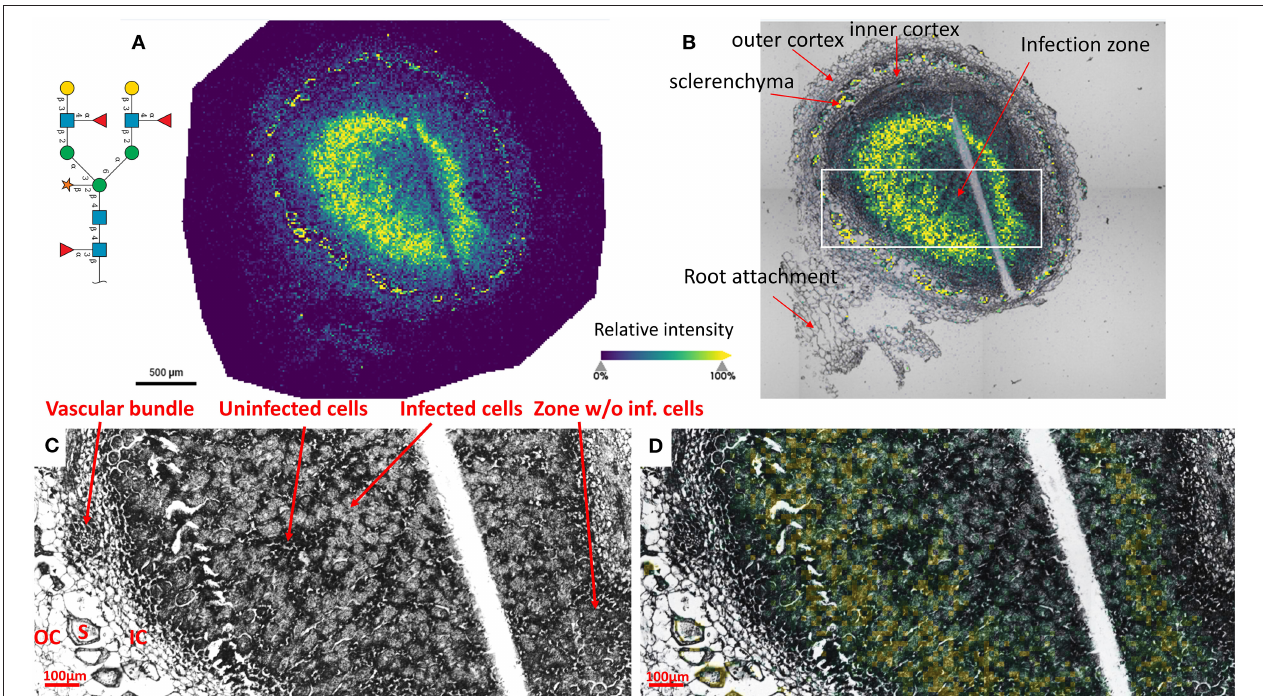
FIGURE 4 | (A) Spatial pattern of Hex:5 HexNAc:4 dHex:3 Pent:1 glycan in nifH- nodule at 15 µ m spatial resolution. (B) Morphologically and functionally different cell types and zones inside soybean root nodules are annotated. A white rectangle denotes an area that is enlarged on (C,D) for better visualization of fine morphological details. (C,D) Zoomed area inside the infection zone with annotated infected and uninfected cells indicate a higher abundance of N -glycans in the infected cells (bigger and lighter cells) compared to non-infected cells (smaller and darker). Vascular bundles, inner cortex (IC), outer cortex (OC), and sclerenchyma (S) cells are also annotated. Glycan signal was seen primarily in the infected cells. Some glycan signal was also seen in the sclerenchyma. The scale bar at A and B is 500 µ m and at C and D is 100 µ m. Note that a thin crack along the infection zone is a sectioning artifact and is an indication that there is no delocalization of the released molecules during the incubation step as no N -glycan signal has been observed in this zone. Interactive display of N -glycans composition, structure, spatial localization, and colocalization with specific cell types can be further browsed, visualized, and explored using the METASPACE link: https://metaspace2020.eu/annotations?db_id=